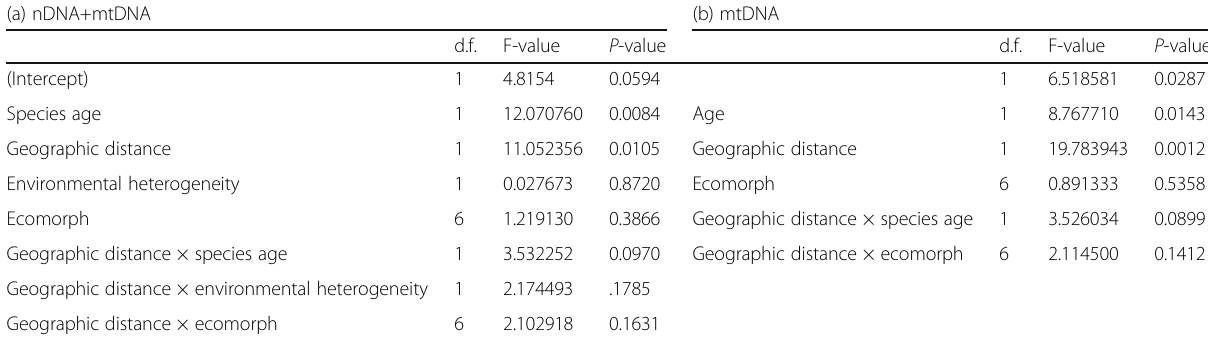
Table 1 Results of phylogenetic generalized least squares (PGLS) analyses for the final model using nuclear DNA (nDNA) and mitochondrial DNA (mtDNA) (a), and mtDNA only (b) (a) nDNA+mtDNA (b)